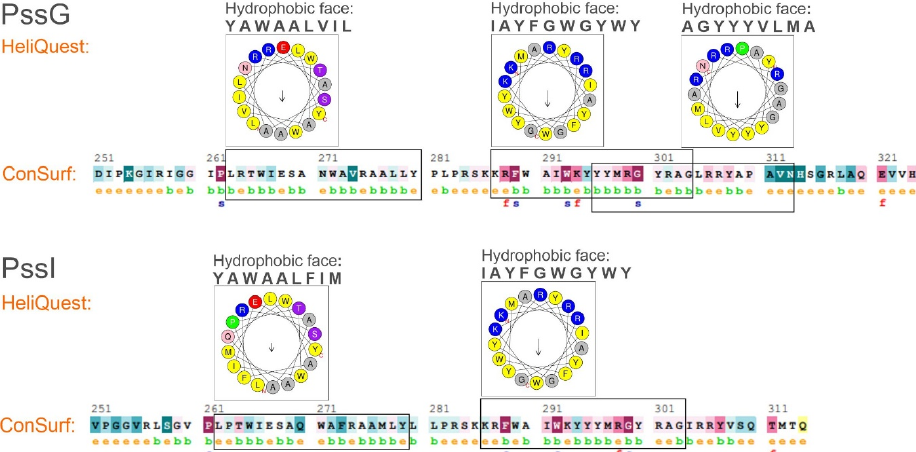
Figure 6. Verification of amphipathic character of C-terminal helices predicted in PssG and PssI proteins. Analyses were performed on C-terminal amino acid sequences, i.e., 251–324 aa for PssG, and 251–314 aa for PssI. HeliQuest: indicated parts of the amino acid sequences were analyzed to find segments, where the so-called ‘hydrophobic face’ could be identified in a helical wheel representation. Analyses were performed with parameters set at α -helices and an 18-aa window. The most representative results, i.e., the longest hydrophobic faces with poorly hydrophobic and polar residues on the opposite side of the helical wheel, were shown, and the corresponding amino acid sequences were framed. ConSurf: e—exposed residue, b—buried residues, f—functional residue (highly conserved and exposed), and s—structural residues (highly conserved and buried).